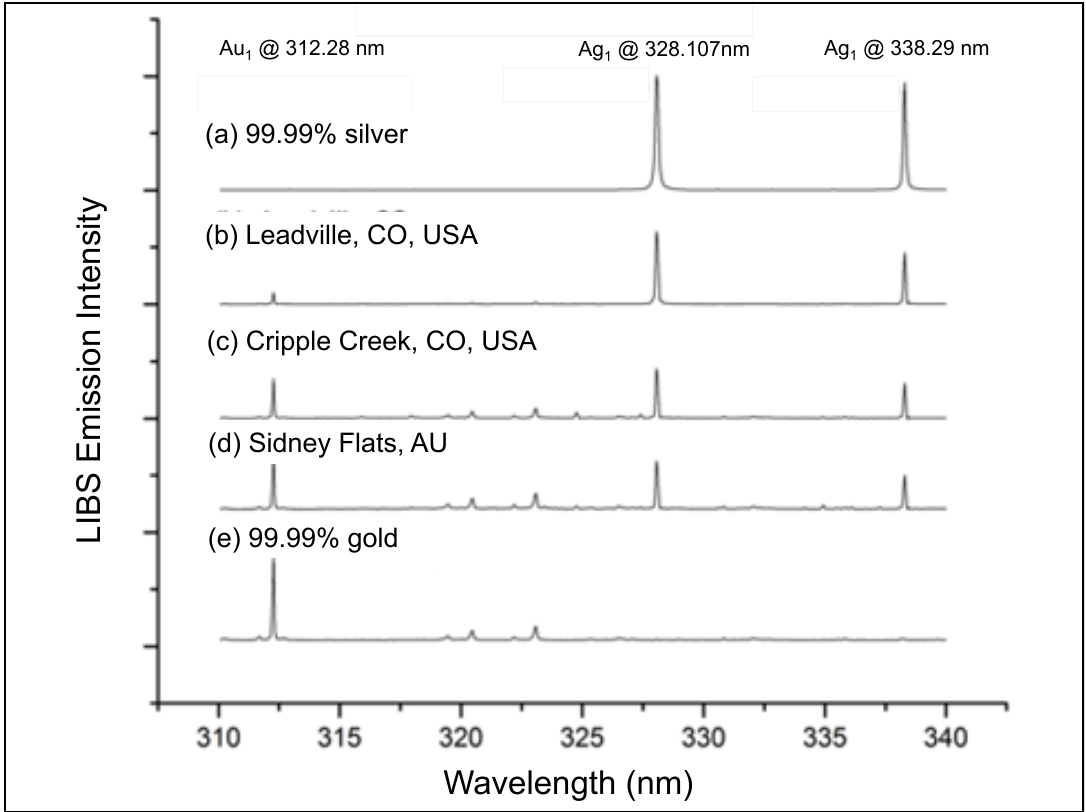
Figure 8. LIBS emission spectra between 305 and 345 nm for pure silver ( a ), placer gold samples from Leadville, Colorado, USA ( b ), Cripple Creek, Colorado, USA ( c ), and Sidney Flats, Australia ( d ), and pure gold (modified from Harmon et al. [79]). See text for